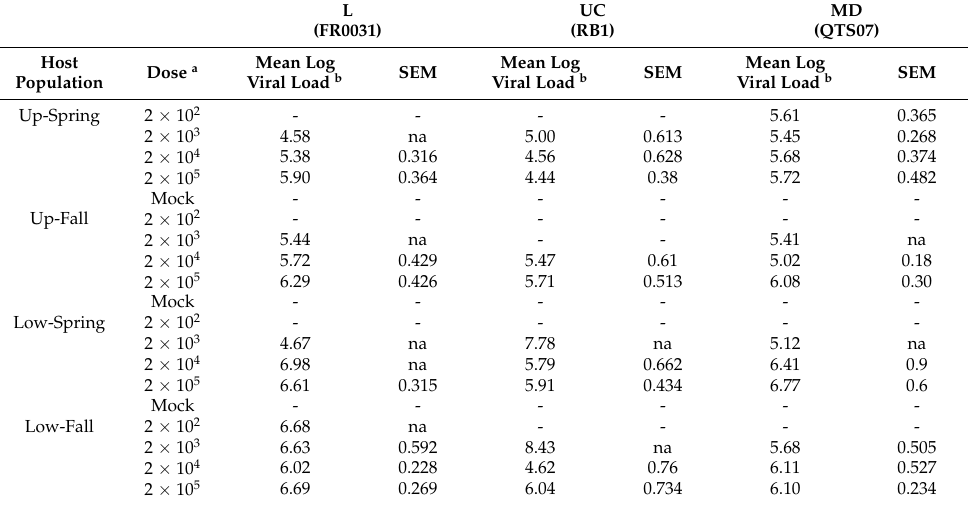
Table 3. Quantities of IHN virus detected in 1 g spring- and fall-run Chinook salmon of the upper and lower CRB at 3 days post exposure to L, UC, or MD strains of